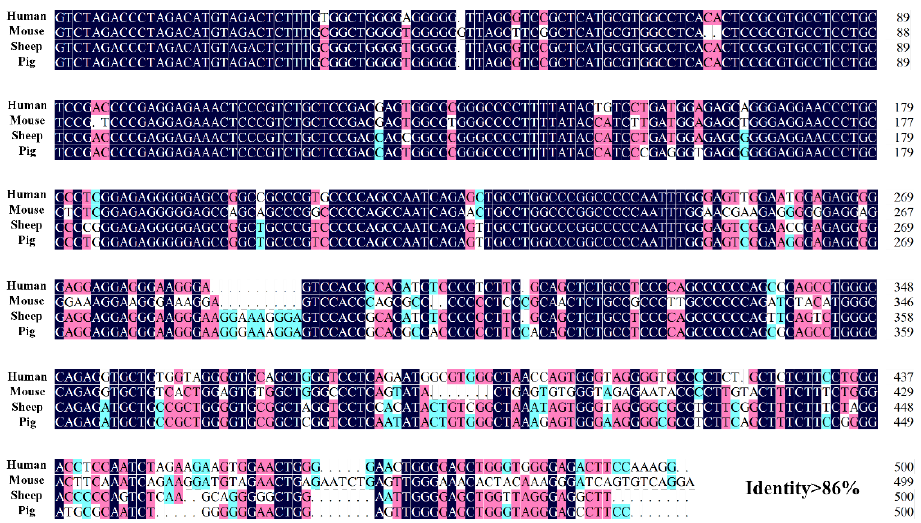
Figure 2. Sequence alignment of 500 bp before the initiation codon of COL1A1 in human, mouse, sheep, and pig.